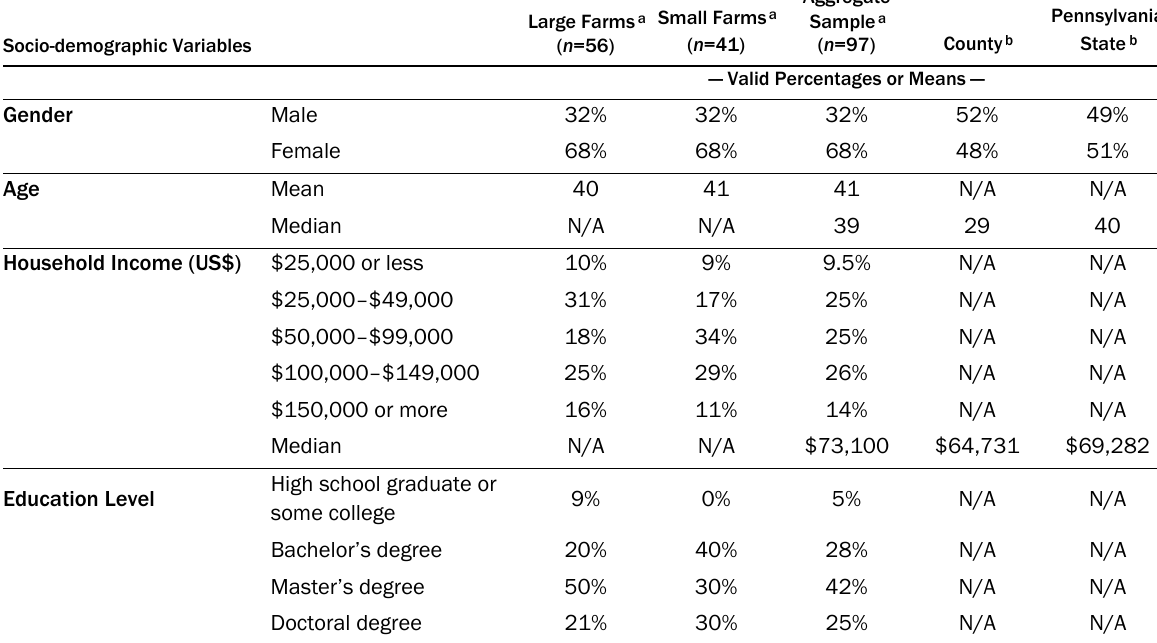
Socio-demographic Variables